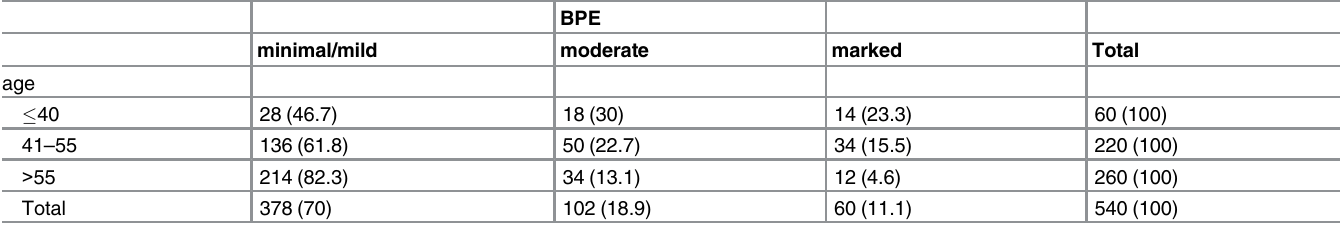
Table 3. Cross-tabulation of age groups and BPE.